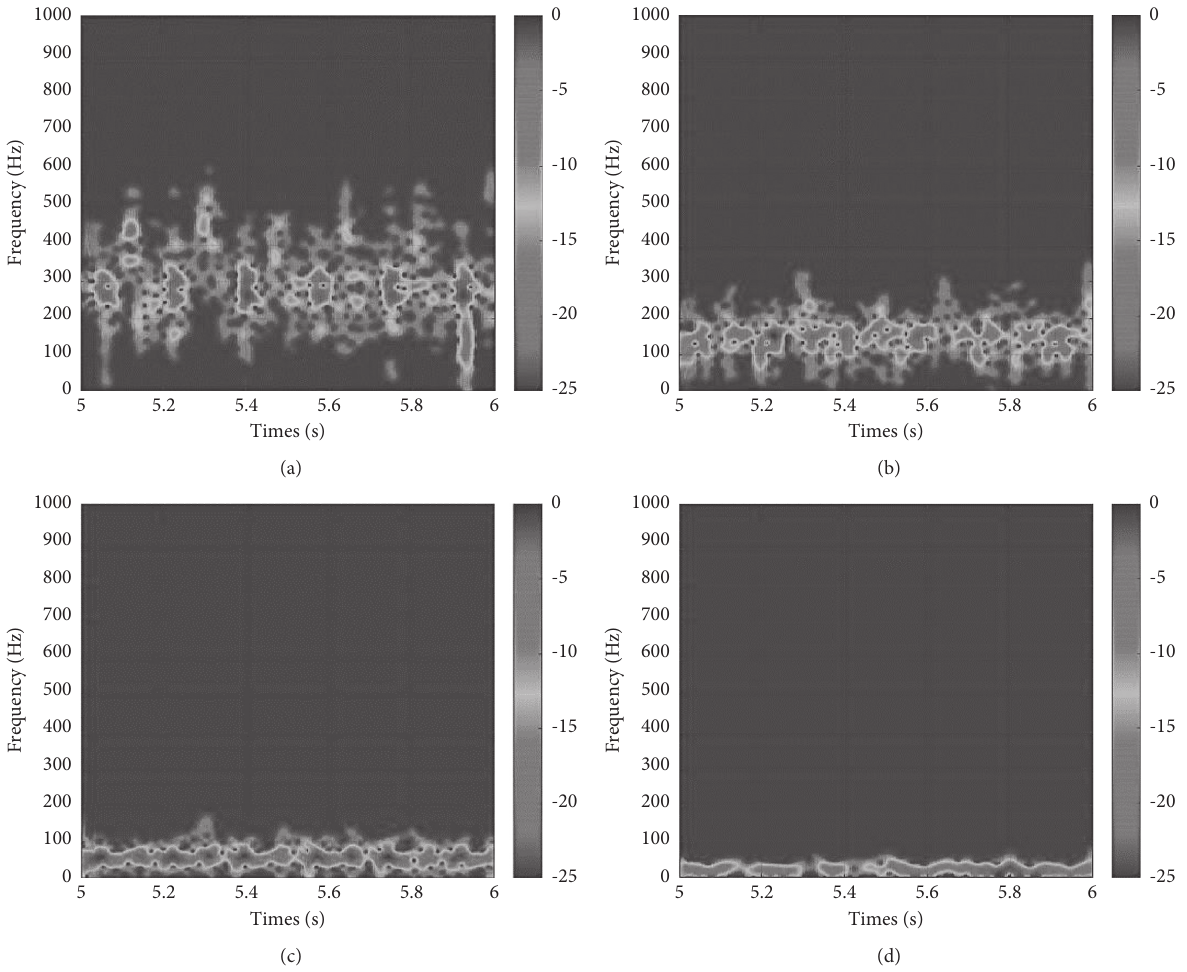
Figure 9: (a) Time-frequency of IMF1. (b) Time-frequency of IMF2. (c) Time-frequency of IMF3. (d) Time-frequency of IMF4.